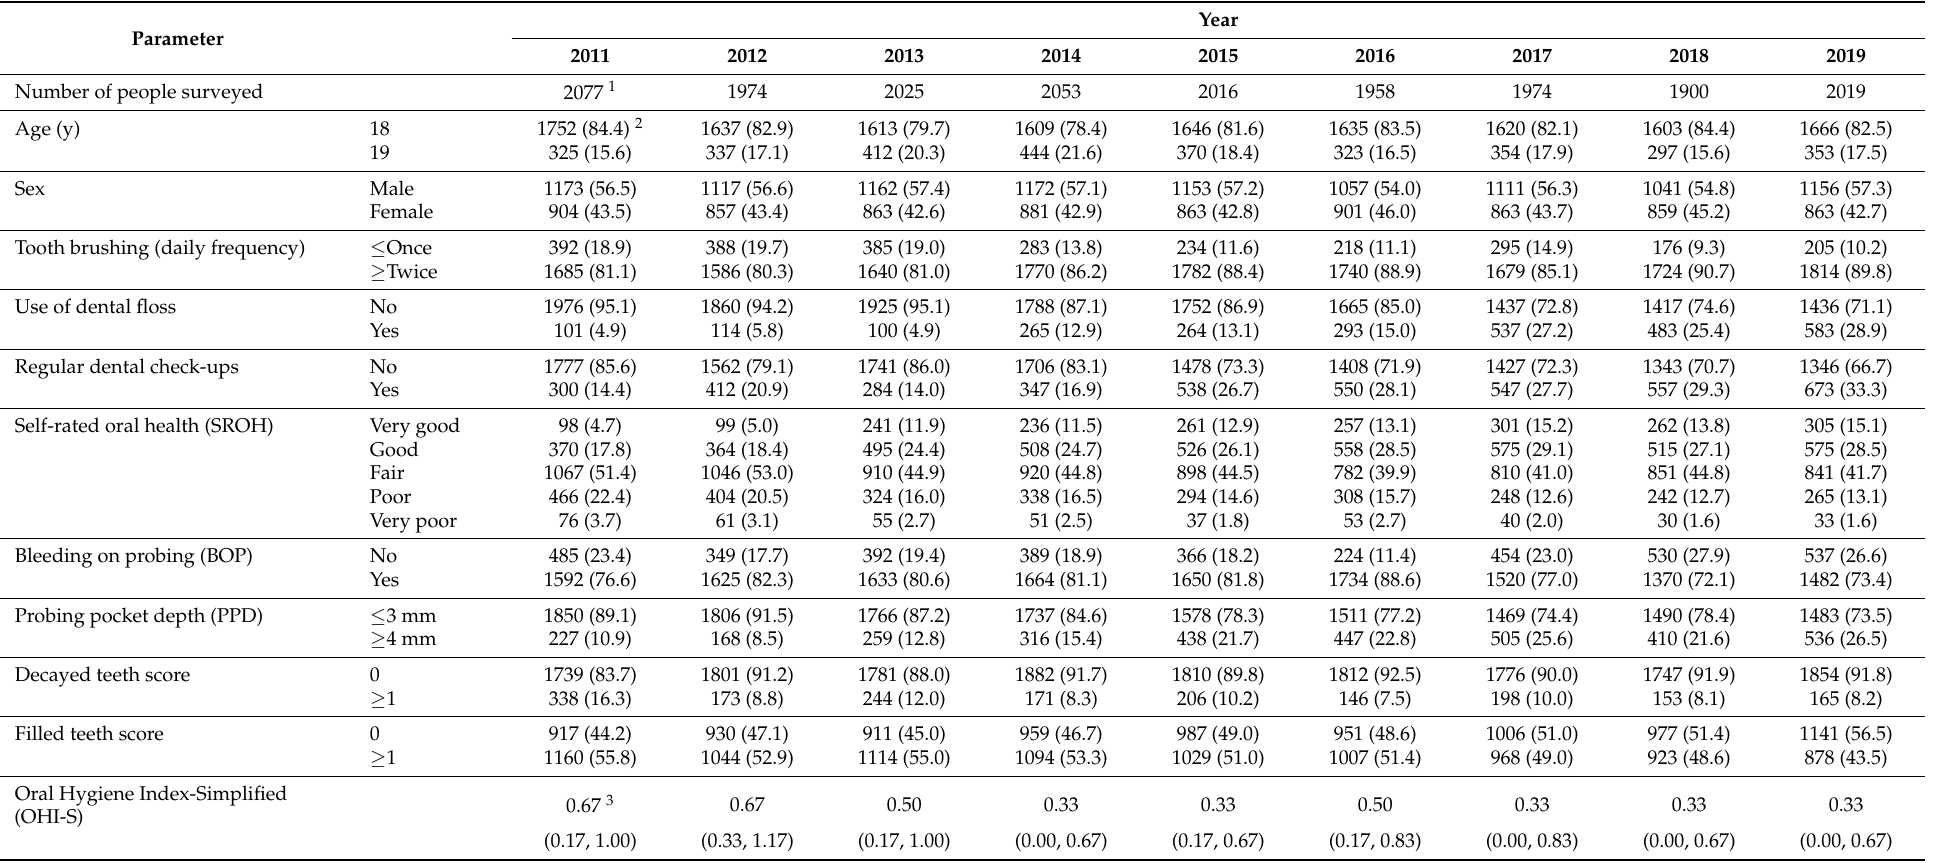
Table 1. Participants’ characteristics ( n = 17,996), Japanese university students,